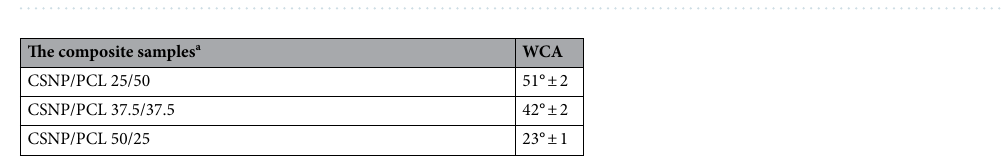
Table 2. Surface wettability of the composite scaffolds. a All samples had a constant concentration of chitosan (25% w/w), n = 6.